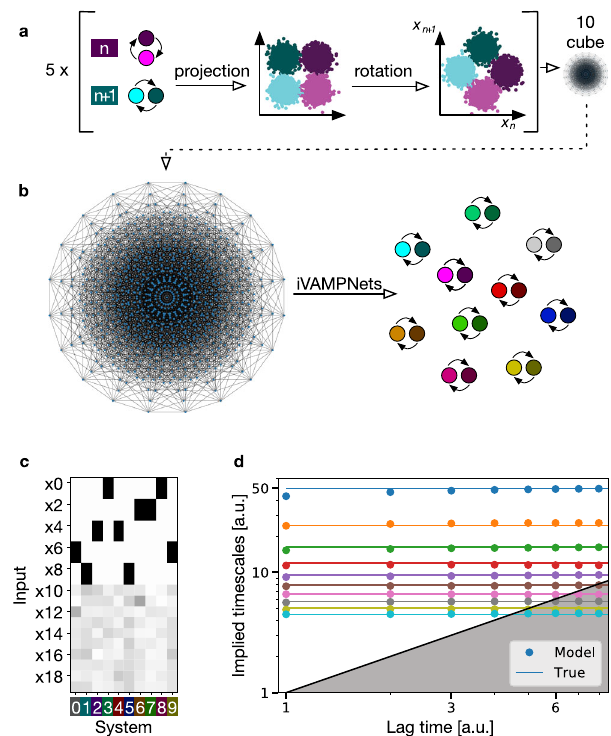
Fig. 4 | Hidden Markov state model with 1024 global states forming a 10D hypercube embedded in a 20D space. a The hypercube is composed of ten independent 2-state subsystems. A pair of two subsystems always lives in a com- monrotated2D-manifold.Therefore,twosubsystemsneedthesameinputfeatures to be well approximated. b 2D depiction of the hypercube in an orthographic projection 89,90 , where the global system can jump freely between all 1024 vertices, and the ten 2-state models retrieved from it by the iVAMPnet (colors denote sub- systemidentity). c Learnedmask,depictedingray-scalefrom0(white)to1(black), assigninginputstosubsystems(color-coded).Itshowsthatforeachsubsystem,the networkassigns twohighlyimportant input features whichare shared with exactly one other subsystem, mirroring the rotated input space. Noise dimensions (x10- x19) are assigned low importance values. d Implied timescales as a function of the model lag time (both in arbitrary units, a.u.) of all ten subsystems learned by our method (dots) approximate the underlying true timescales (lines). Time scales are color-coded by